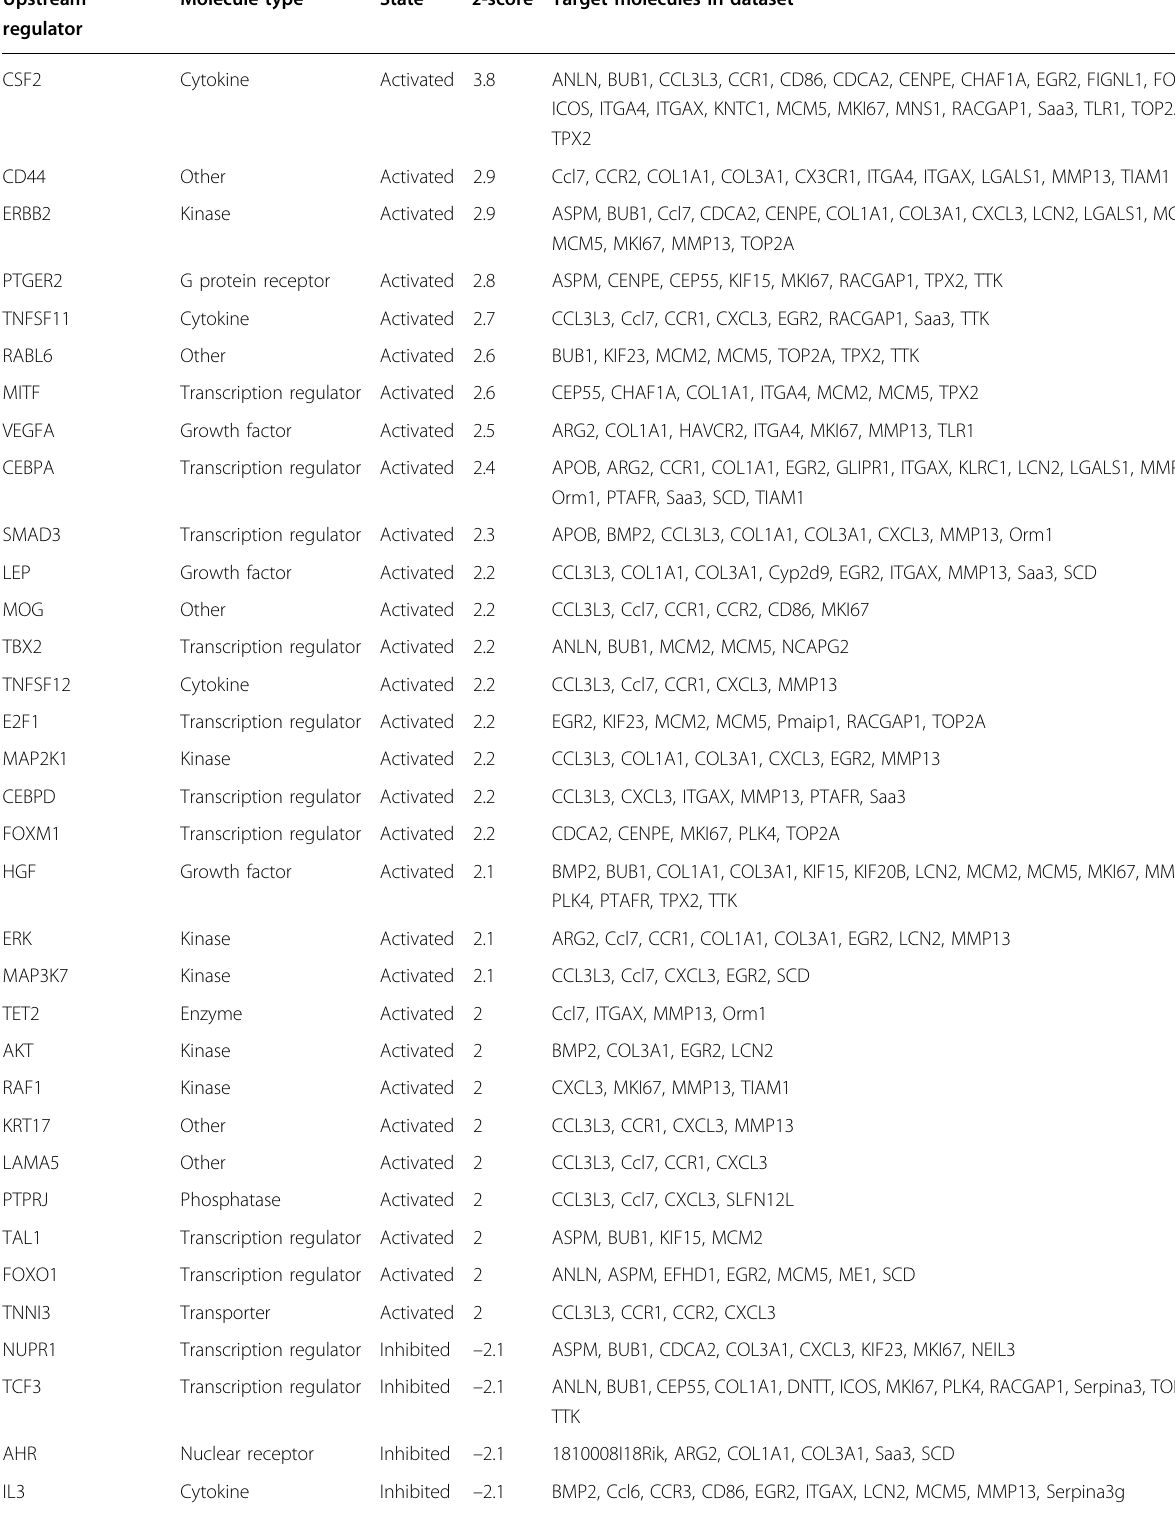
Table 2 Upstream regulators of genes in the Apob-silenced signature from mouse livers